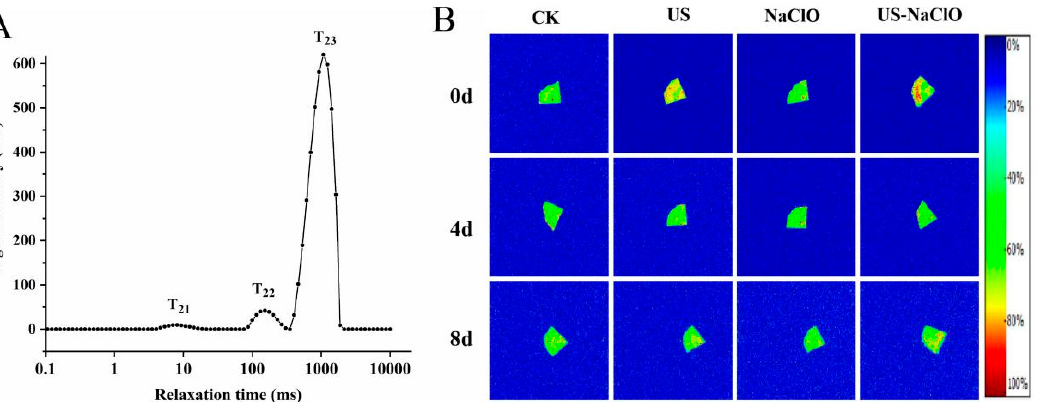
Figure 3. Distribution of transverse relaxation times (T 2 ) in fresh-cut cucumber (T 21 : bound water, T 22 : fixed water, T 23 : free water) ( A ) and pseudo-color images of fresh-cut cucumber under different treatments during storage ( B ).